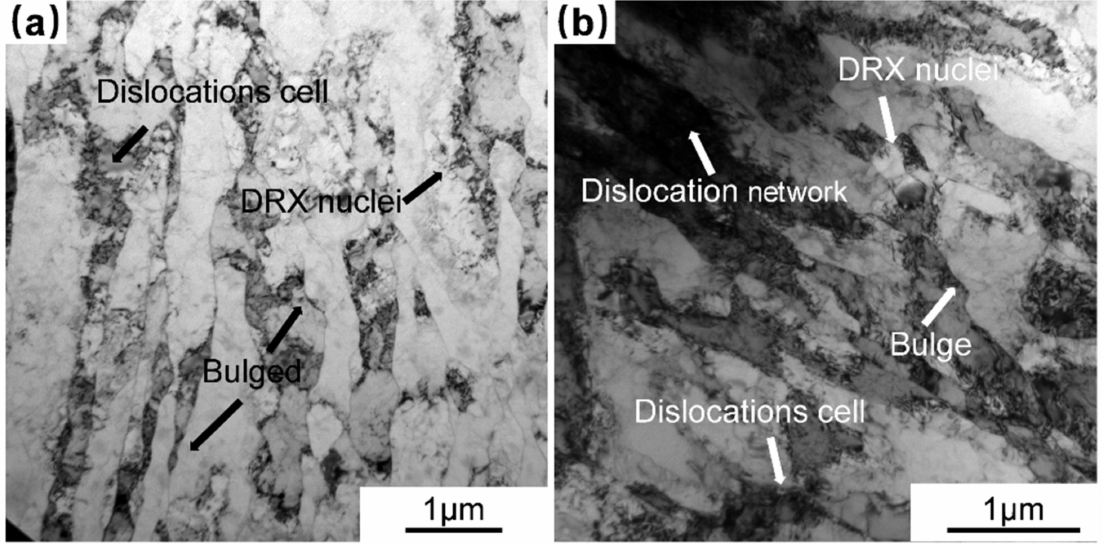
Figure 13. DRX behavior of the nickel-based alloy 825 deformed at ( a ) 850 ◦ C (0.14 s − 1 ), and ( b ) 850 ◦ C (2.72 s − 1